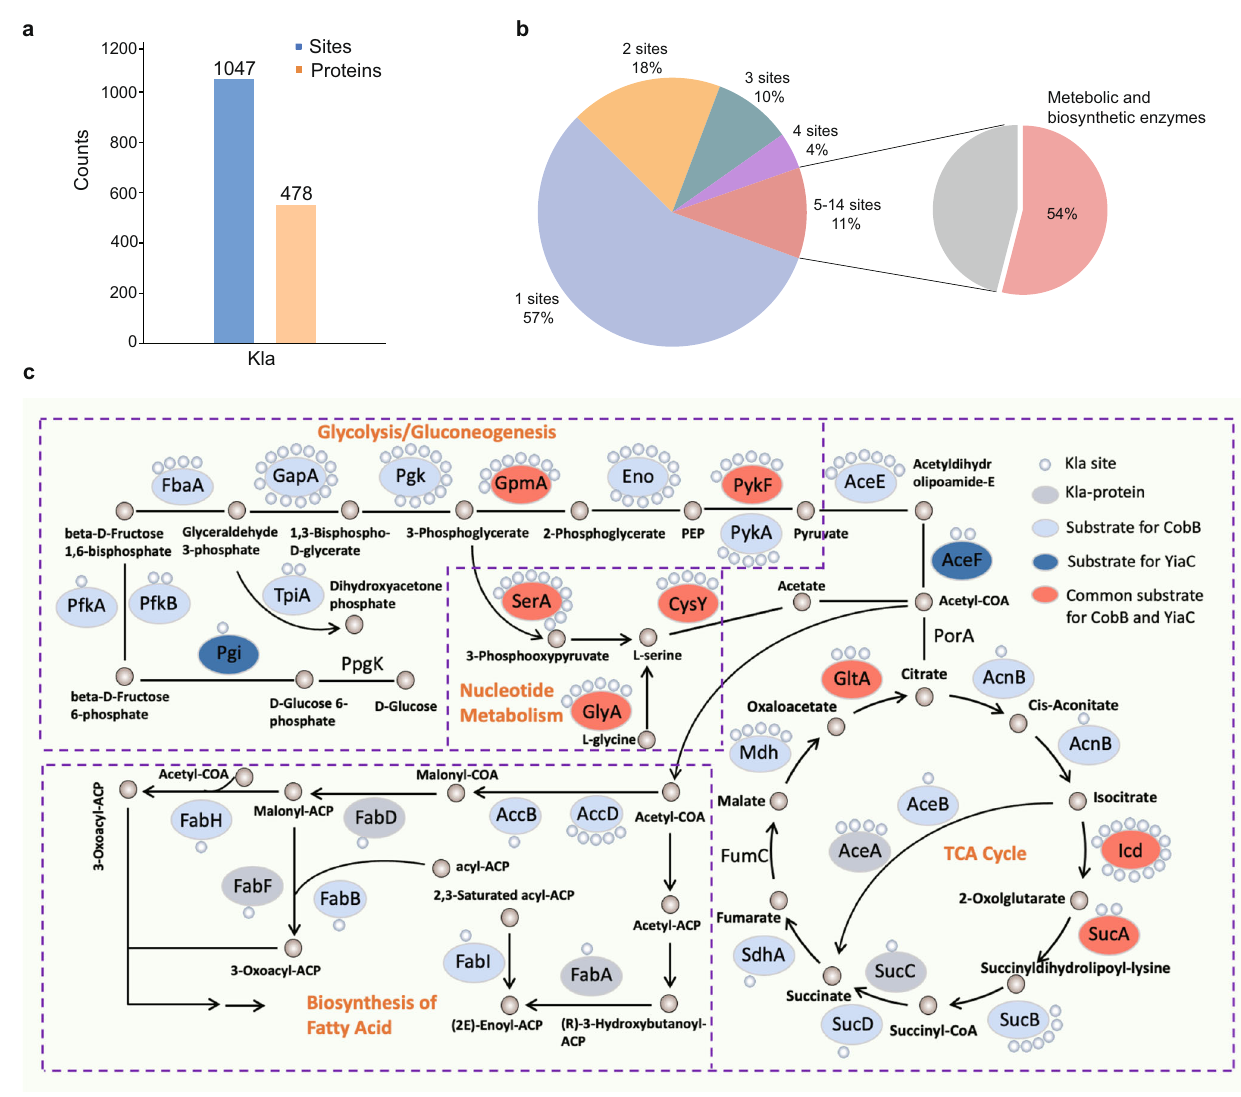
Fig. 4 | Characterization of the Kla proteome in E. coli . a Statistics analysis of the Kla proteins and sites of E. coli . b The frequency of Kla occurs on proteins. c The lactylated enzymes in central carbon metabolism and fatty acid biosynthesis network in E. coli